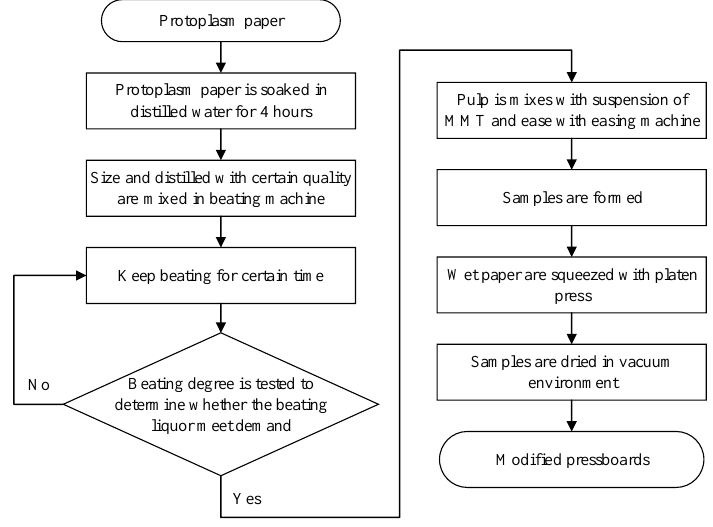
Figure 1. The flow diagram follow for creating nano-modified insulating pressboard.